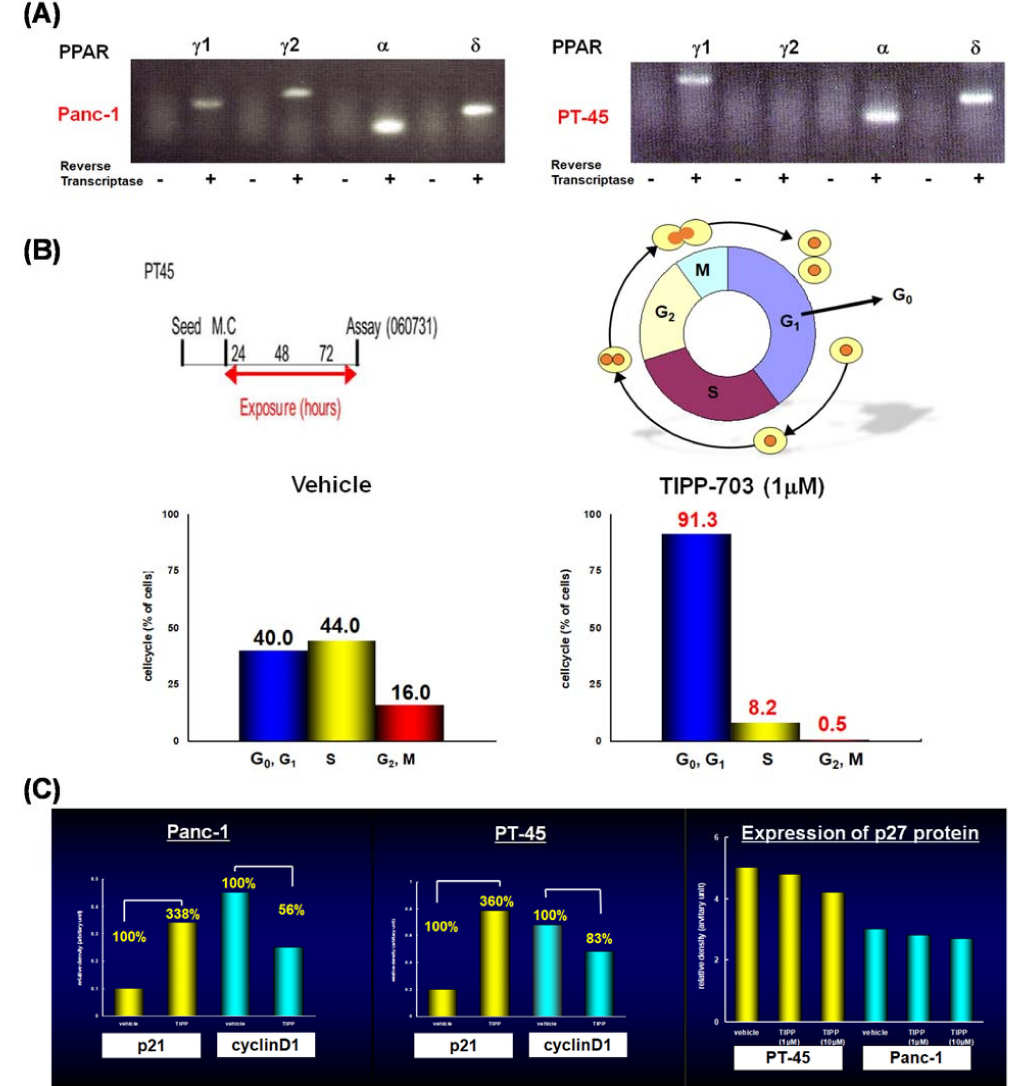
Figure 15. ( A ) Expression of PPAR subtypes in PANC-1, and PT-45 cells. ( B ) Effect of TIPP-703 on the cell cycle of PT-45 cells. ( C ) Effect of TIPP-703 on the expression of P21, cyclinD1, and p27 in both PANC-1 and PT-45